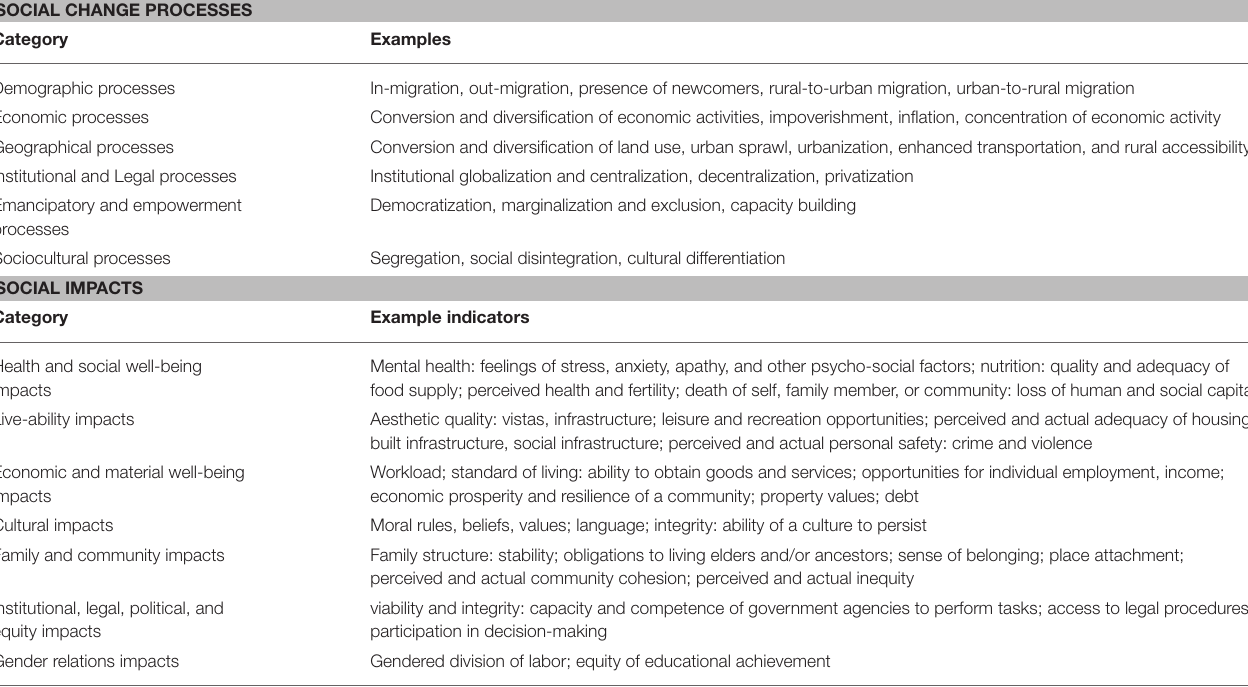
TABLE 2 | Adapted from Vanclay